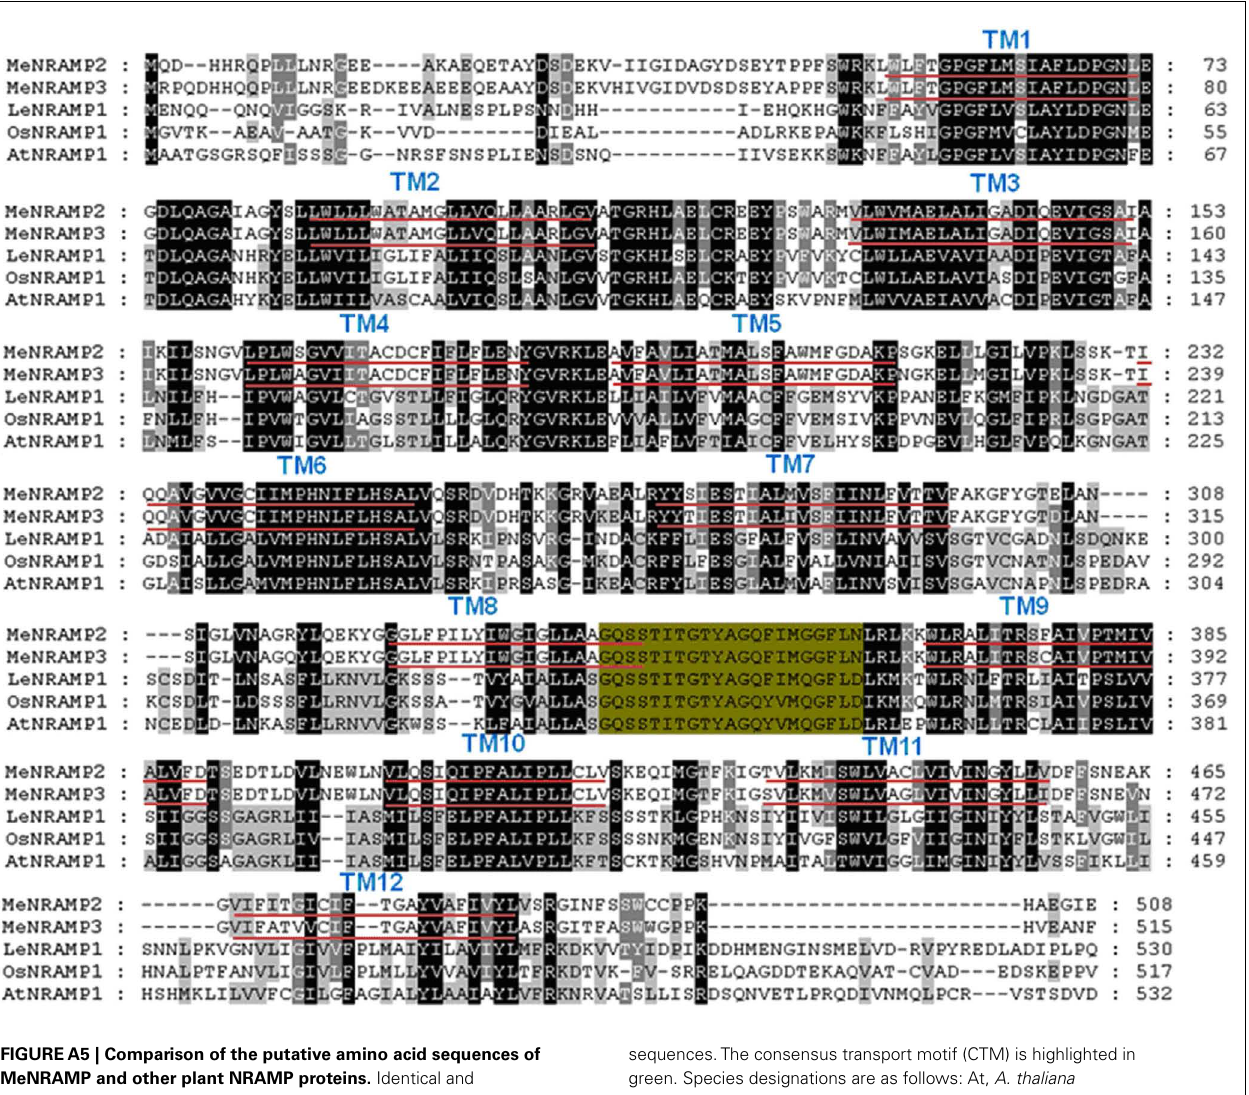
FIGUREA5 | Comparison of the putative amino acid sequences of MeNRAMP and other plant NRAMP proteins. Identical and conservative amino acids are shaded in black and gray, respectively. Dashes indicate gaps.Twelve transmembrane domains (TM) were identified usingTMHMM and are shown as red lines below the